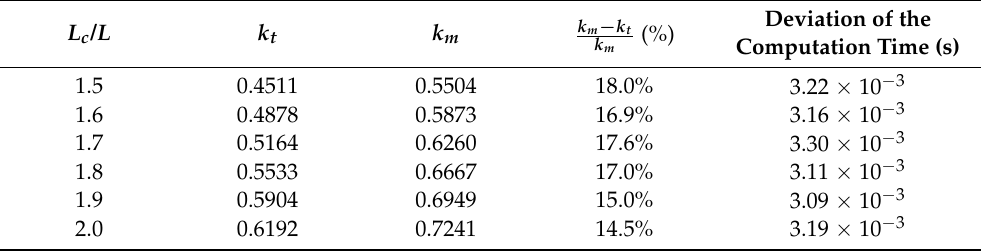
Table 6. The effective thermal conductivity in triangle pores compared with the EMT